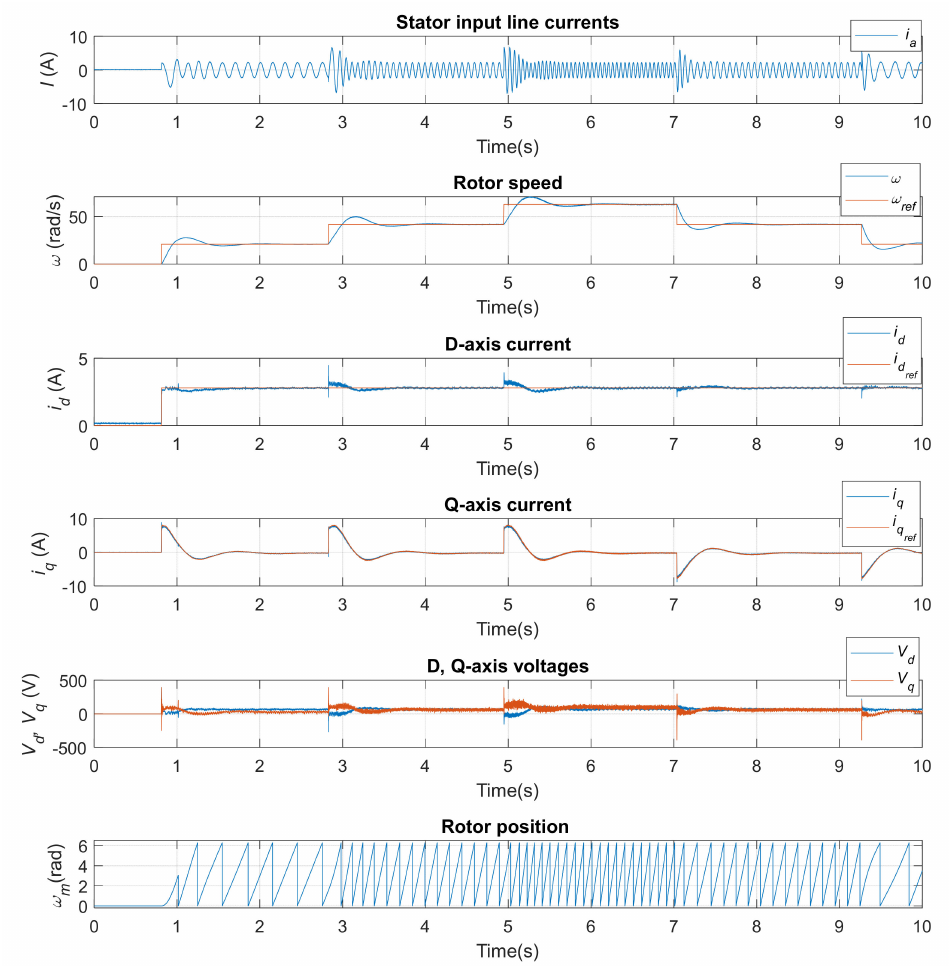
Figure 17. Speed step response in different speeds; I a : the measured phase a current, ω : the measures speed ( ω ) and the reference speed ( ω ref ), i d : the direct axis current ( i d ) and the direct axis current reference ( i dref ), i q : the quadrature axis current ( i q ) and the quadrature axis current reference ( i qref ), V dq : the direct and quadrature axis voltages, θ m : the mechanical angle of the